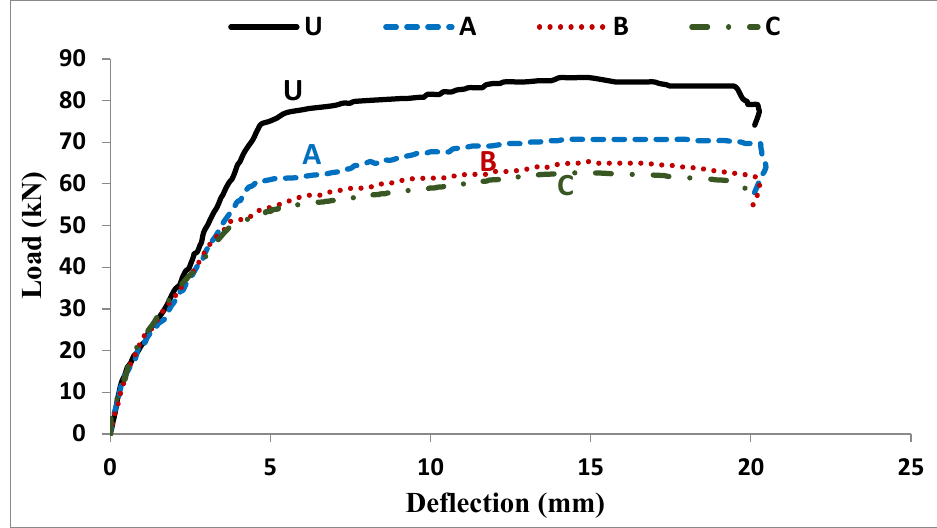
Figure 13. Load–midspan deflection curves for control and corroded beams.